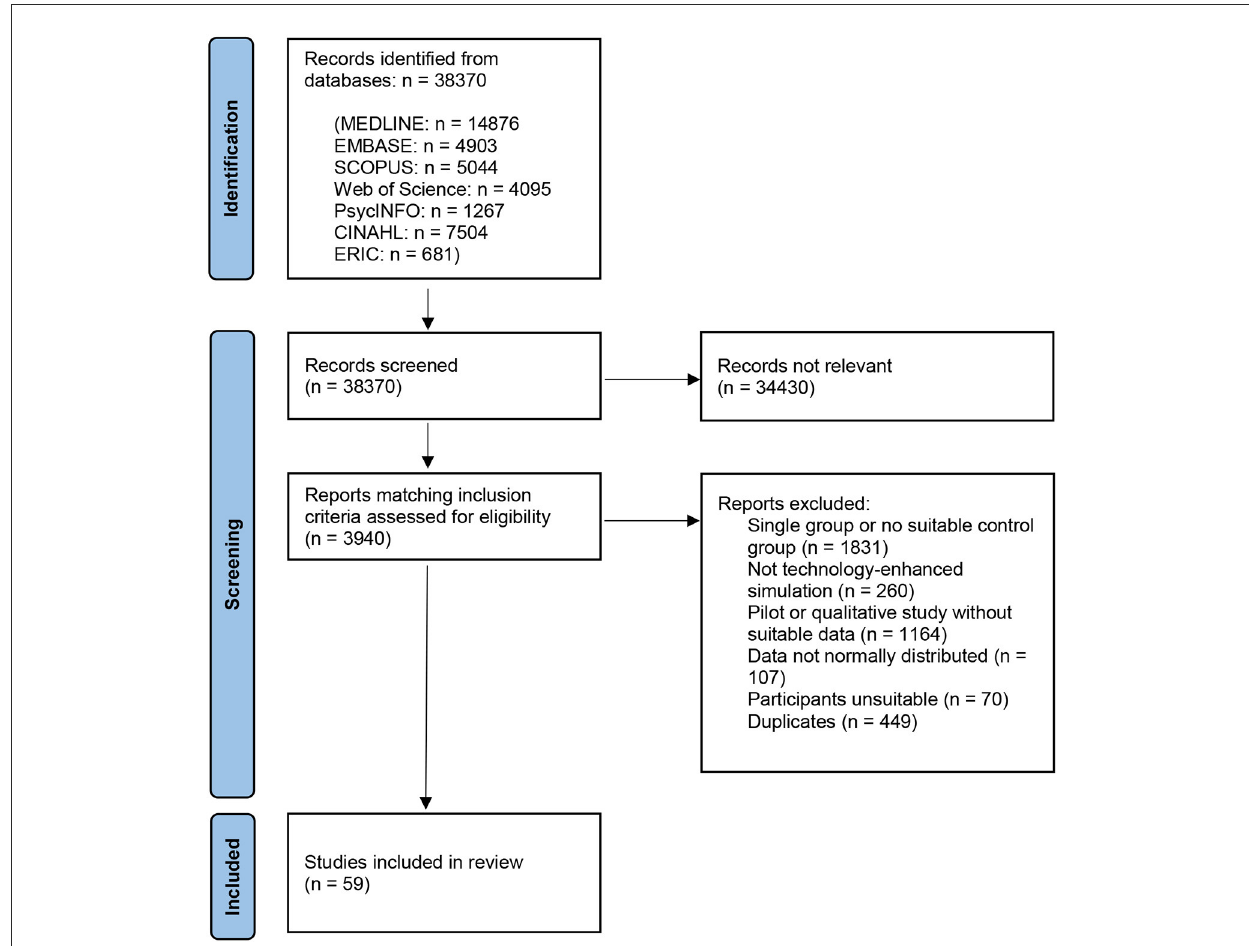
FIGURE1 PRISMA flow chart—of 38,370 studies screened, 3,940 abstracts were searched in detail, of which 449 were duplicates–59 studies were included overall, with 136 individual effect sizes analyzed.